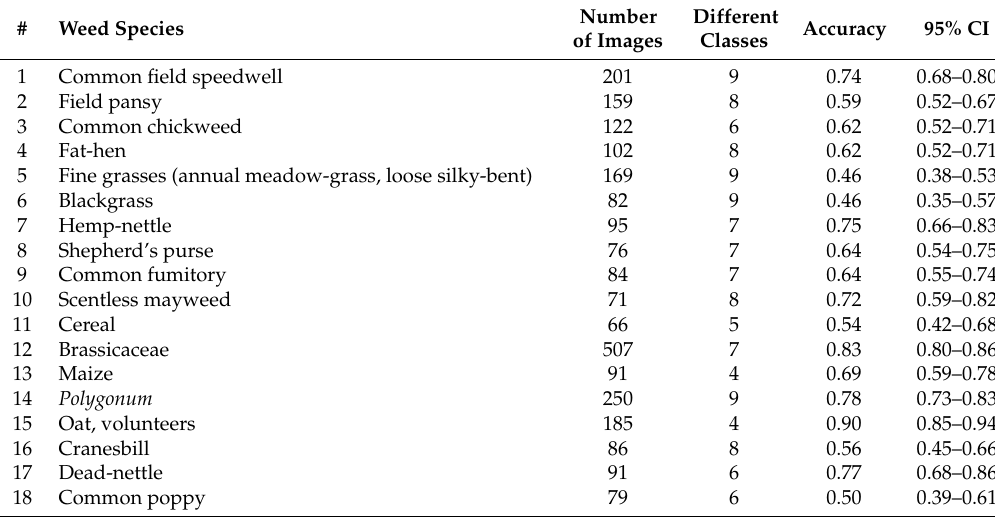
Table 2. Evaluating the accuracies of different weed species using Wilson’s confidence approach with 10,000 iterations in the validation